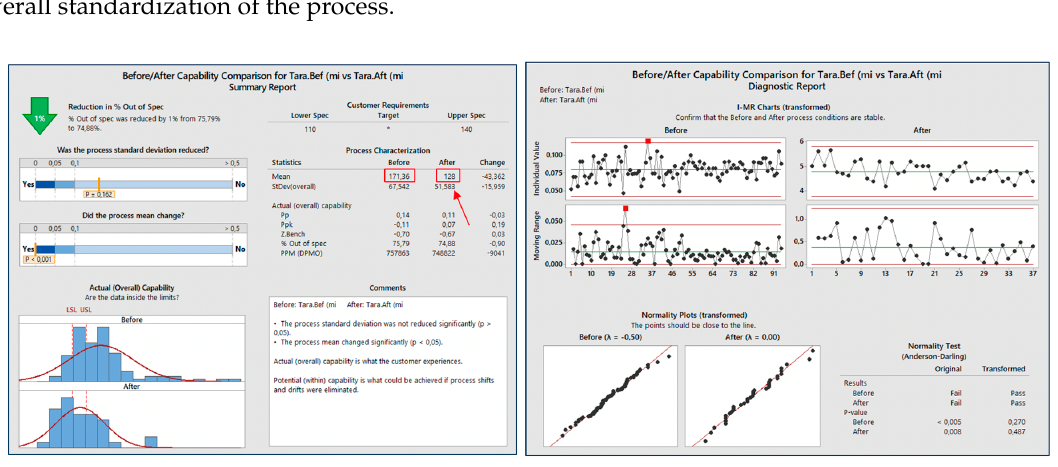
Figure 9. Medium changeover time improvement. Legend: I-MR (Individual-Moving Range), Pp (Process performance), Ppk (Process performance value), Z. Bench (Benchmark value), PPM (Parts Per Million), DPMO (Deffects Per Million Opportunities), LSL (Lower Specification Limit), USL (Upper Specification Limit).